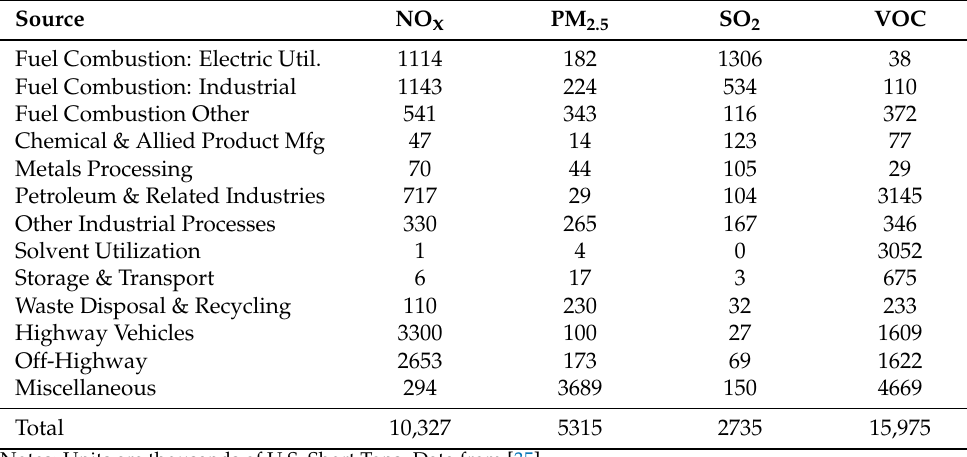
Table A1. Overall air pollution emissions by source, 2018.